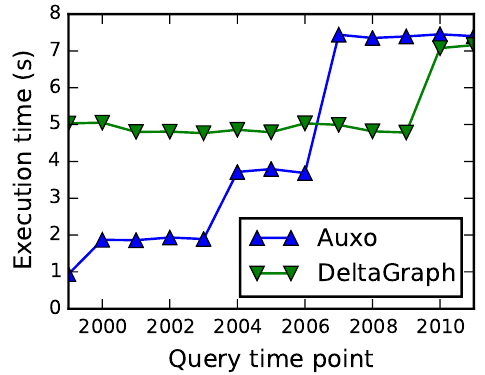
Fig. 13 Comparison of Auxo and DeltaGraph (dblp graph).